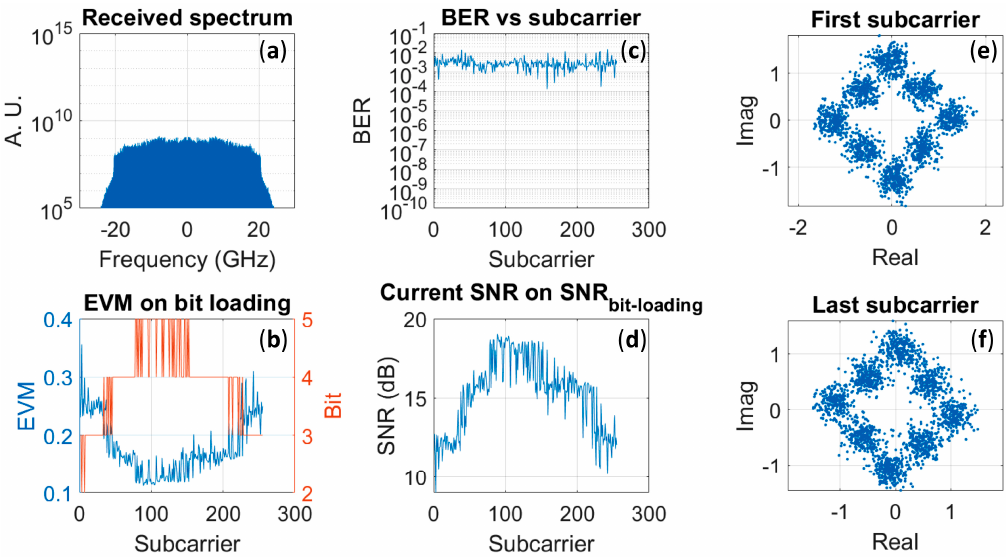
Figure 5. ( a – f ) Tunable VCSEL: SSB DMT for single WSS filtering (9.5 ‐ GHz detuned) and 40 ‐ dB OSNR. ( a ) Received electrical spectrum; ( b ) Bit loading and corresponding EVM; ( c ) BER per subcarrier; ( d ) Bit ‐ loading SNR; ( e , f ) Examples of received